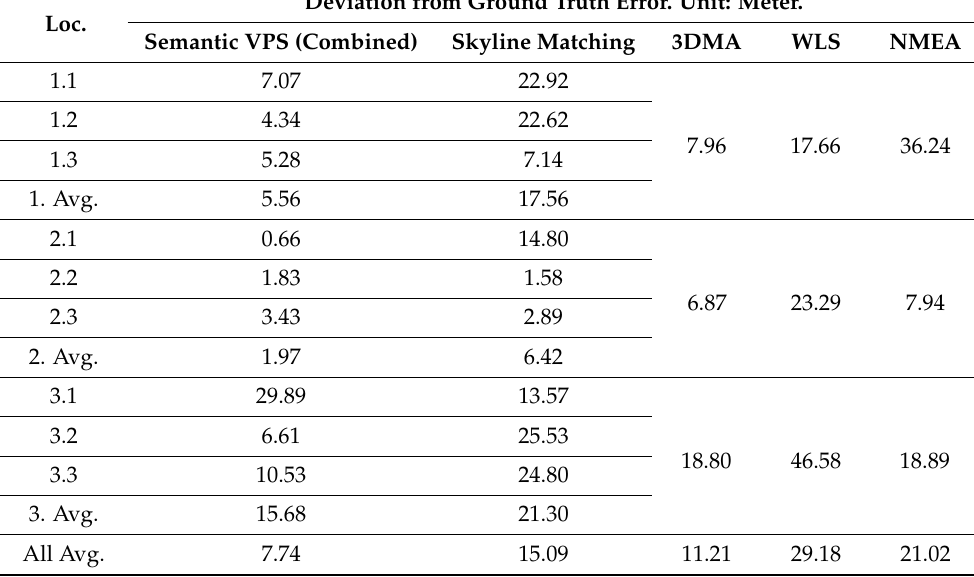
Table 3. Positioning performance comparison of the proposed semantic VPS and other advanced positioning